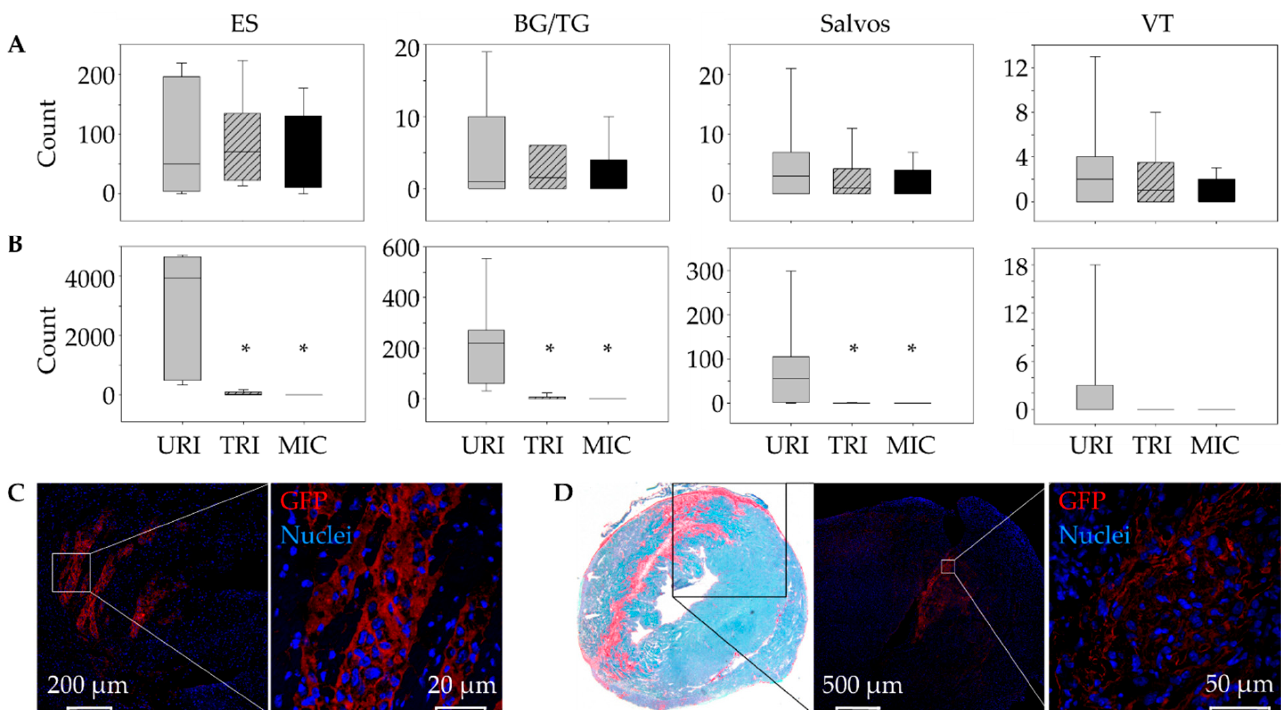
Figure 2. Antiarrhythmic effects of engrafted mesenchymal stem cells (MSC). Comparison of developed ventricular arrhythmias (VA) between 45 min and 12 h post ligation of the left anterior descending artery. While there were no significant differences in terms of the development of VA after the 1st infarction. ( A ), stem cell-treated animals showed significantly reduced VA after the 2nd infarction ( B ). Mean ± SD; * p ≤ 0.05 compared to URI (Mann–Whitney U Test). Detection of GFP+ MSC in heart tissue immediately after transplantation ( C ) and 9 days after the 1st infarction ( D ). ES, extrasystoles; BG/TG Bigemini/Trigemini; VT, ventricular tachycardias; URI, untreated re-infarction, n = 7; TRI, stem cell treated re-infarction, n = 6; MIC, myocardial infarction control, n =